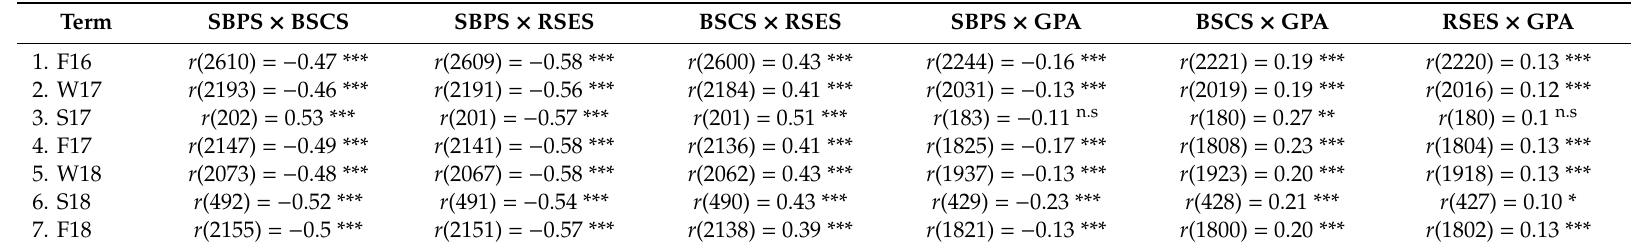
Table 4. Cross Sectional Correlations by Term.